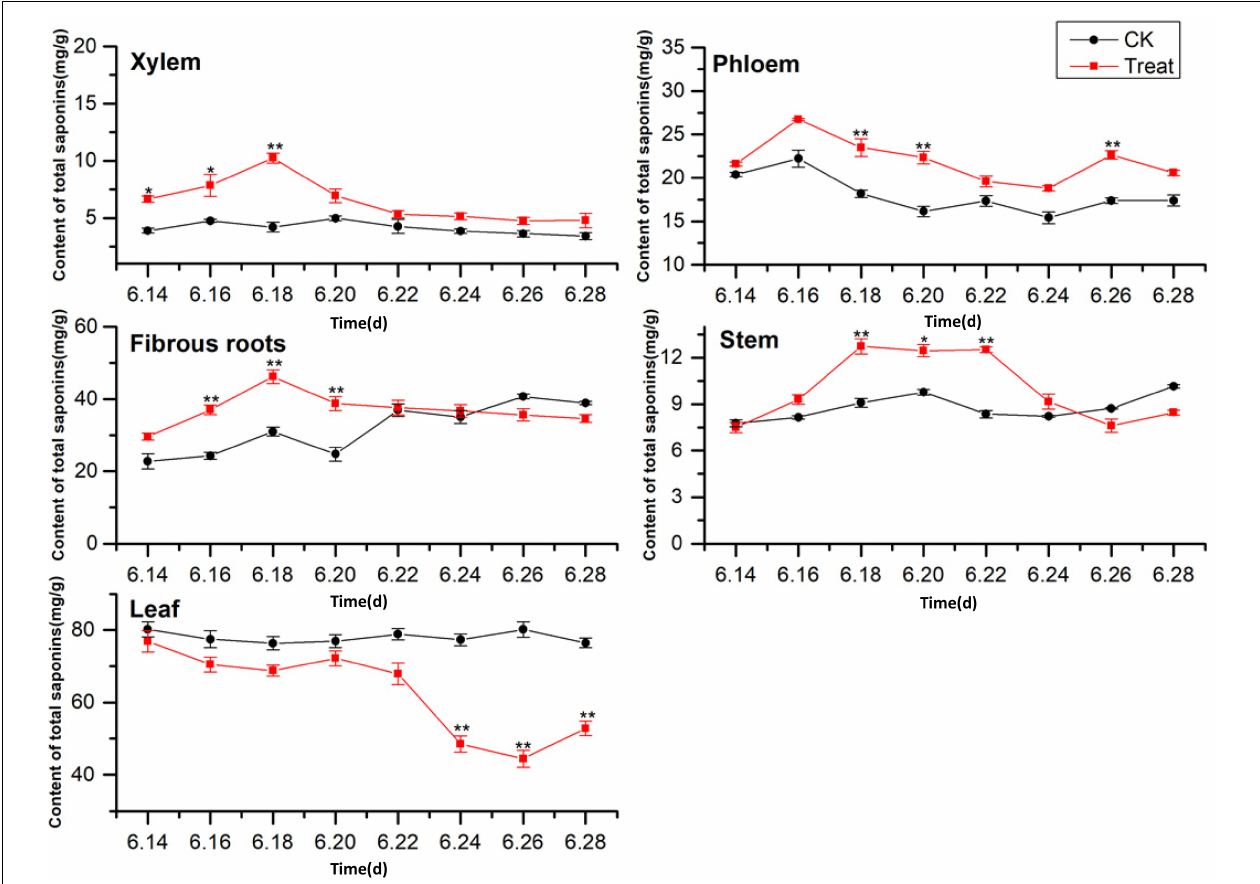
FIGURE 6 | Effects of cold stress on total saponin content in different tissues of flowering ginseng. The X axis represents the sampling time. * p < 0.05 and ** p < 0.01, compared with control group. The data are expressed as the mean ± SD ( n = 3).